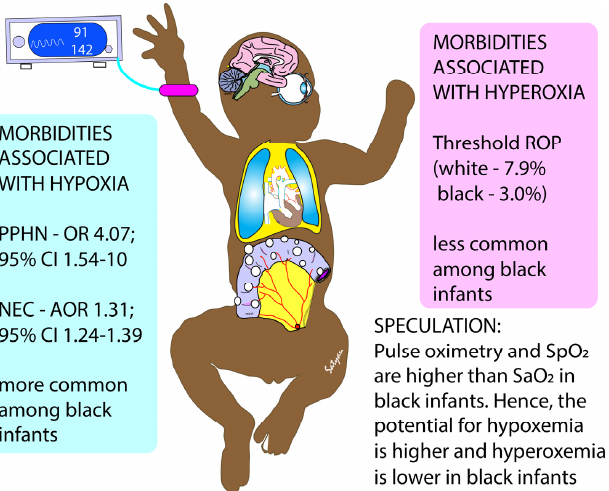
Figure 2. Speculation regarding the basis for increased incidence of morbidities associated with hypoxia among black neonates and those associated with hyperoxia among white infants. Copyright Satyan Lakshminrusimha .